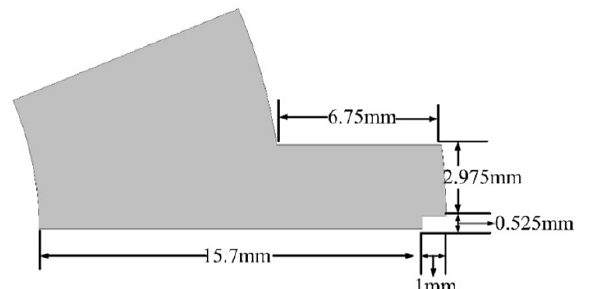
Figure 14. Notching in the rotor pole.